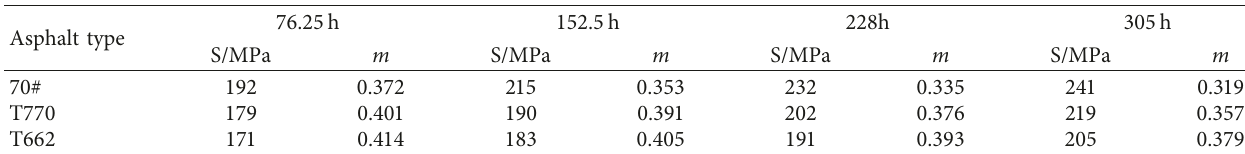
Table 4: BBR bending beam rheological test